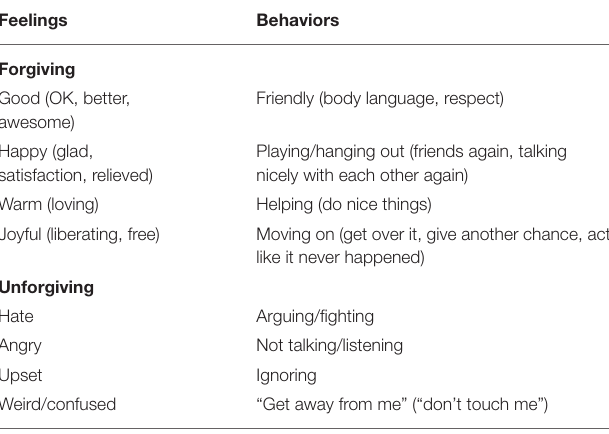
TABLE 1 | Reduced terms representing potential items for a new forgiveness measure. Feelings